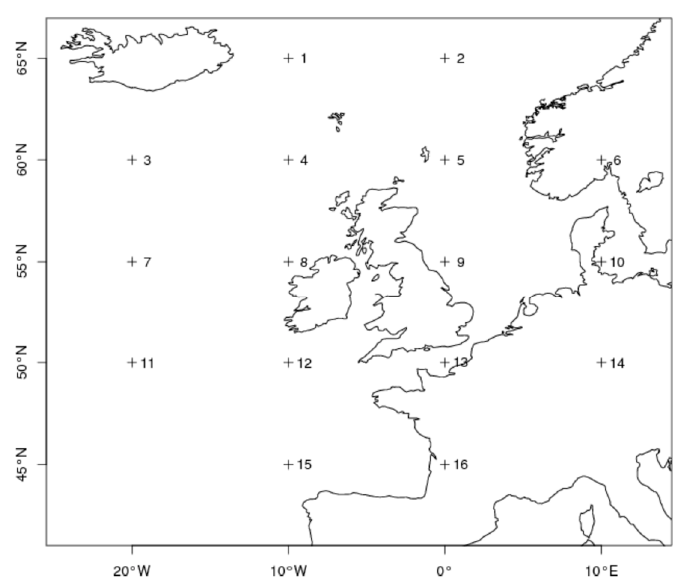
Figure 1. Grid points used to calculate Jenkinson flow and vorticity terms for the British Isles (BI). Numbers refer to those points used in Equations 1-5.